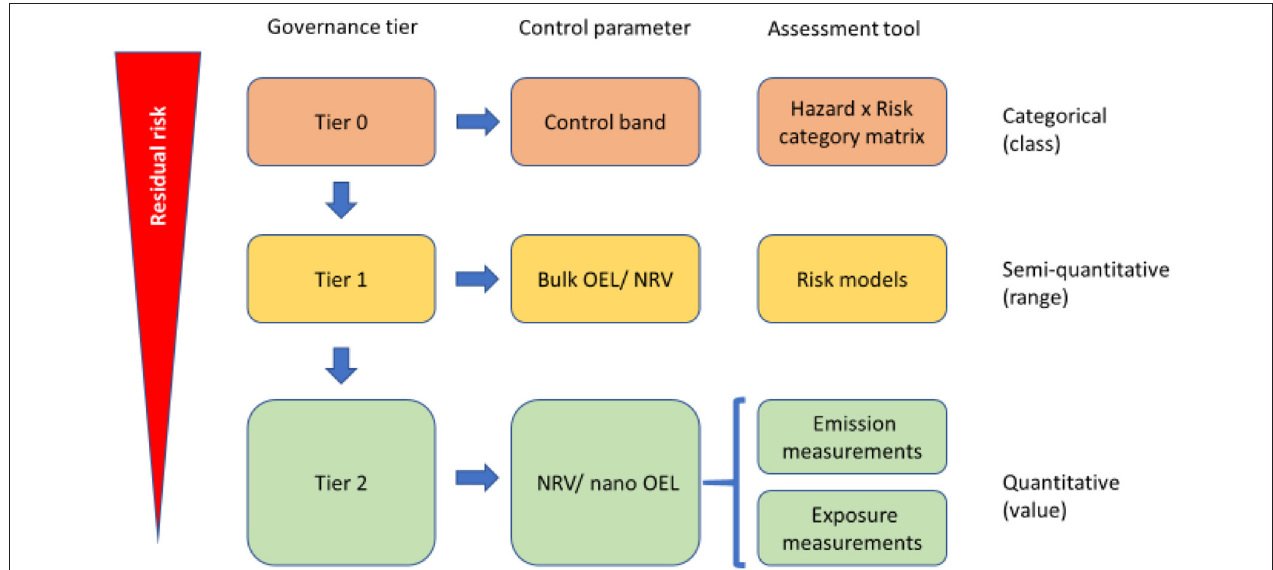
FIGURE 1 | NanoStreeM risk assessment and control methodology